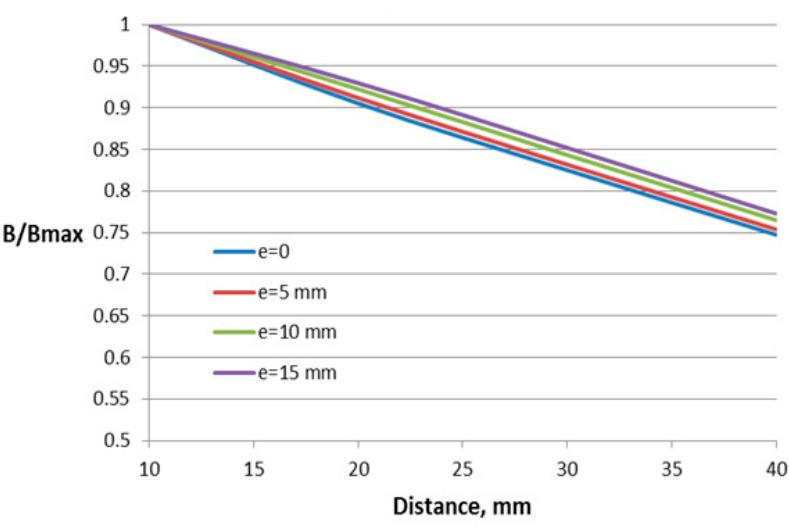
Figure 12. Dependence of the flux density on the distance to the conductor for the concentrator with two gaps and different conductor deflections in the transversal direction e .